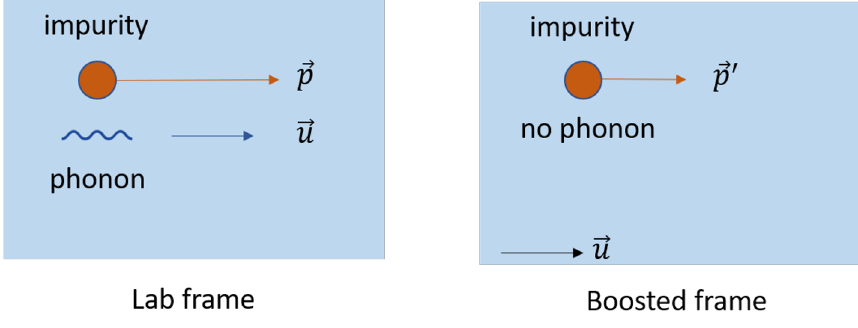
Figure 2 . Impurity and phonon in a superfluid. The left system is observed in the lab frame, while the right system is in a boosted frame with vanishing phonon